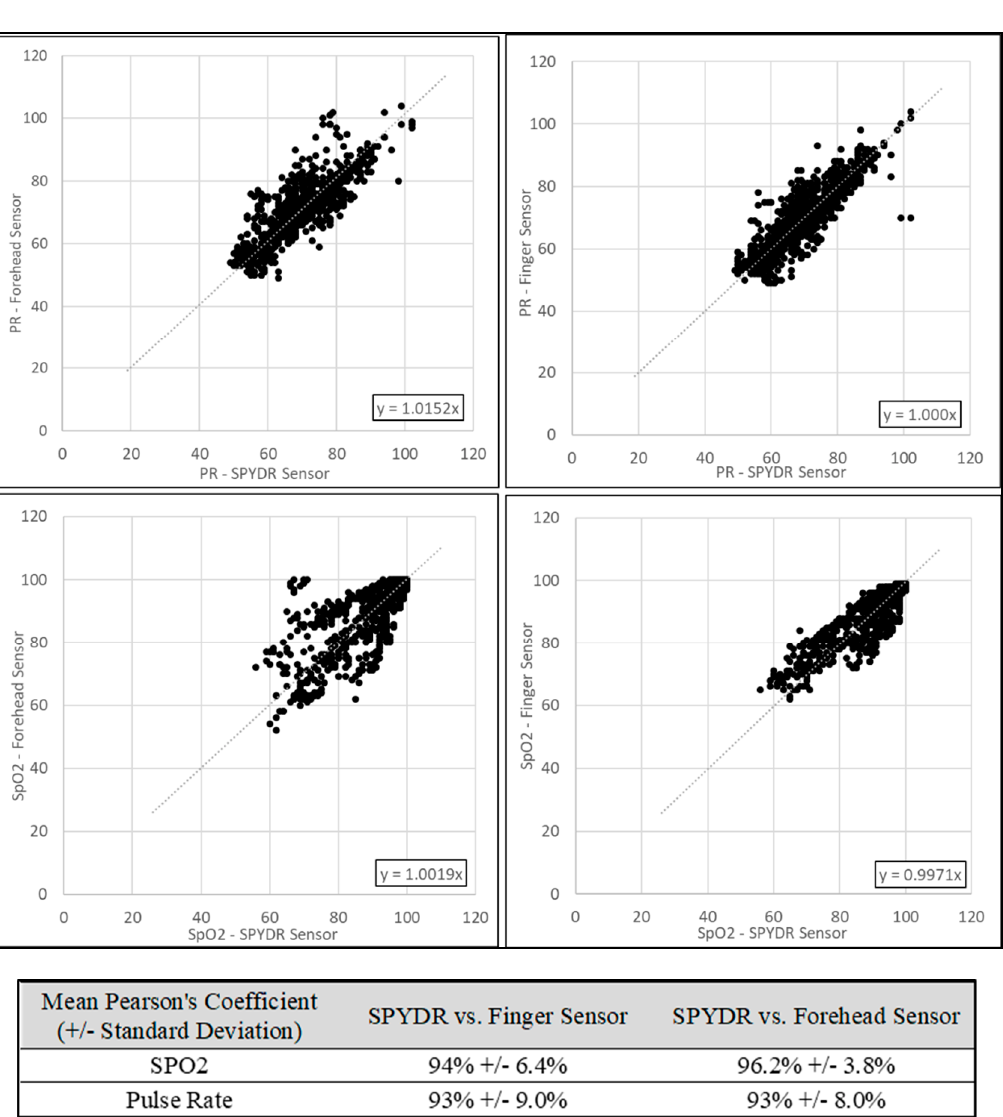
Figure 4. Correlation plots for ( A ) forehead pulse rate vs. SPYDR pulse rate; ( B ) finger pulse rate vs. SPYDR pulse rate; ( C ) forehead SpO 2 vs. SPYDR SpO 2 ; and ( D ) finger SpO 2 vs. SPYDR SpO 2 . The linear relationship shown in each case suggests a high correlation between SPYDR and the respective commercial sensor.